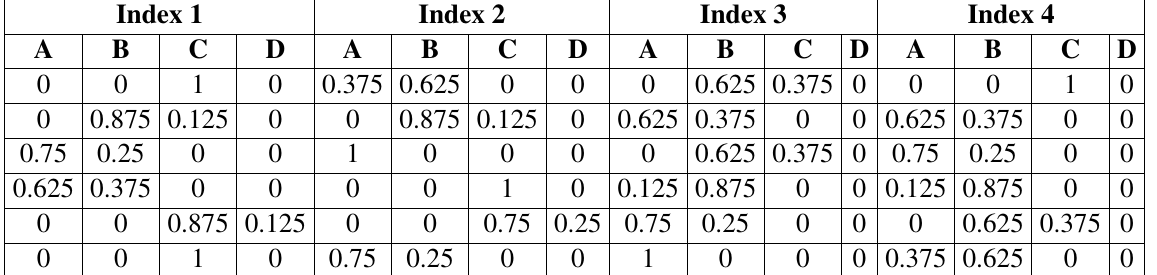
Table 4 The data after fuzzy processed.